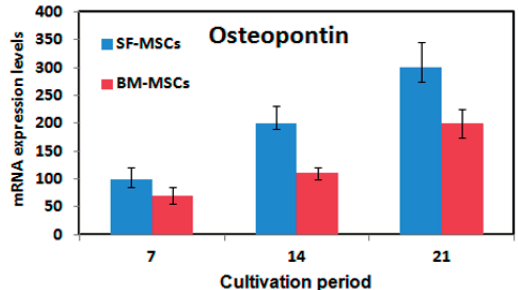
Figure 3. Evaluation of differentiation potential of SF-MSCs and bone marrow (BM)-MSCs by gene expressions. Gene expression profiles of SF-MSCs and BM-MSCs after osteogenic, chondrogenic, and adipogenic induction. Among them, type I collagen, osteocalcin, and osteopontin were for osteogenesis; type II collagen and aggrecan were for chondrogenesis; and peroxisome proliferator activated receptor γ 2 (PPA γ 2) and adipocyte protein 2 (aP2) were for adipogenesis, respectively. Three SF-MSCs and BM-MSCs samples were performed for this experiment.